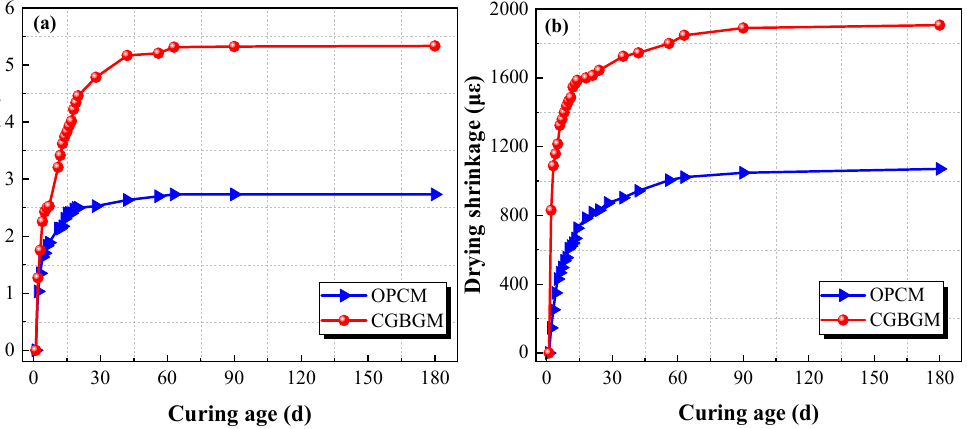
Figure 9. Difference in drying shrinkage behavior of the OPCM and CGBGM: ( a ) mass-loss rate; ( b ) drying